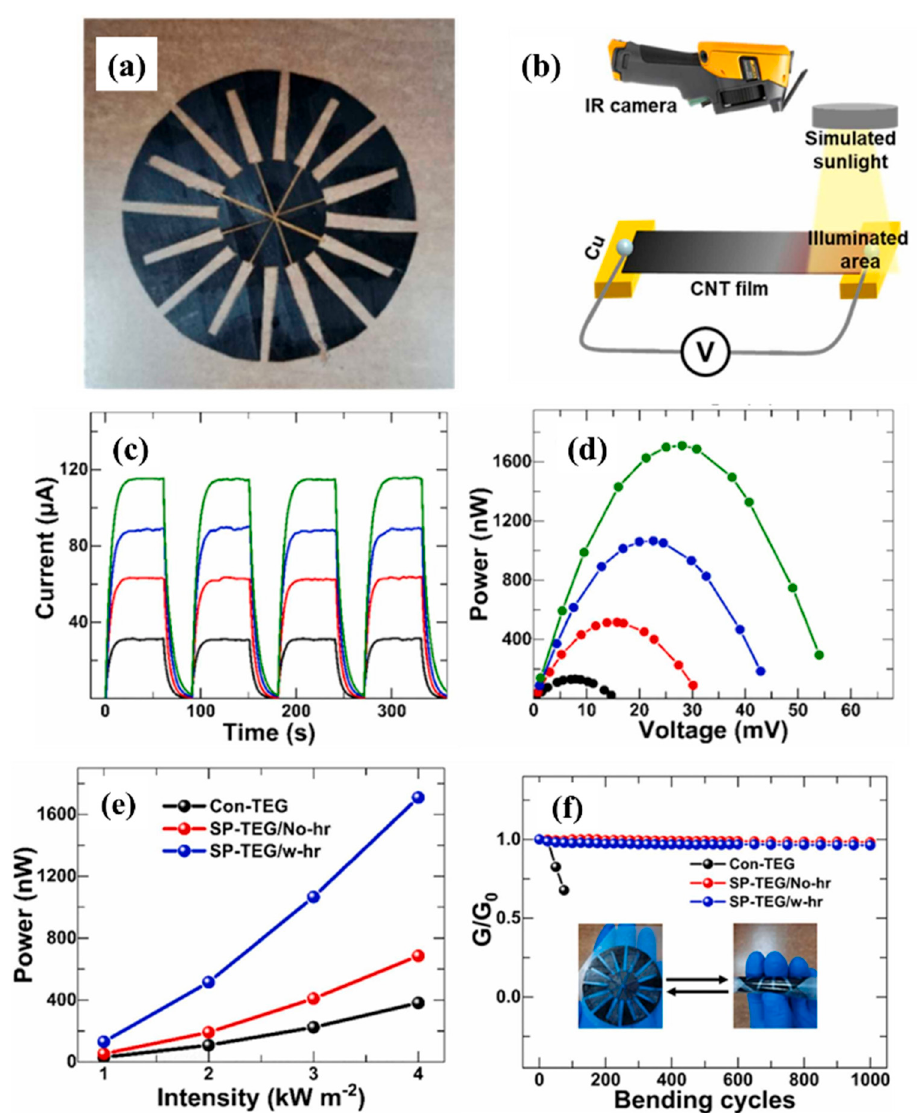
Figure 7. ( a ) Image of a flexible TEG. ( b ) Schematic presentation of the experimental setup. ( c ) The output current response and ( d ) output power-voltage curve of the TEG at different intensities (black, red, blue and green color represents 1 kW/m 2 , 2 kW/m 2 , 3 kW/m 2 and 4 kW/m 2 respectively) ( e ) The maximum output power curve of the Con-TEG and SP-TEG. ( f ) Bending test of the SP-TEG and Con-TEG (reproduced with permission, Copyright 2022 Elsevier